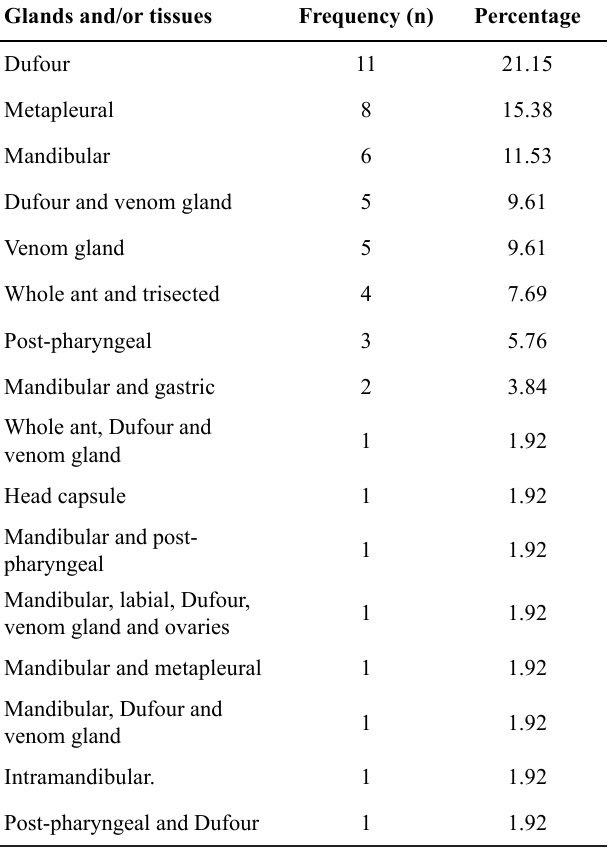
Table 1 . Glands and/or tissues used in the studies conducted for the extraction of substances from ants.